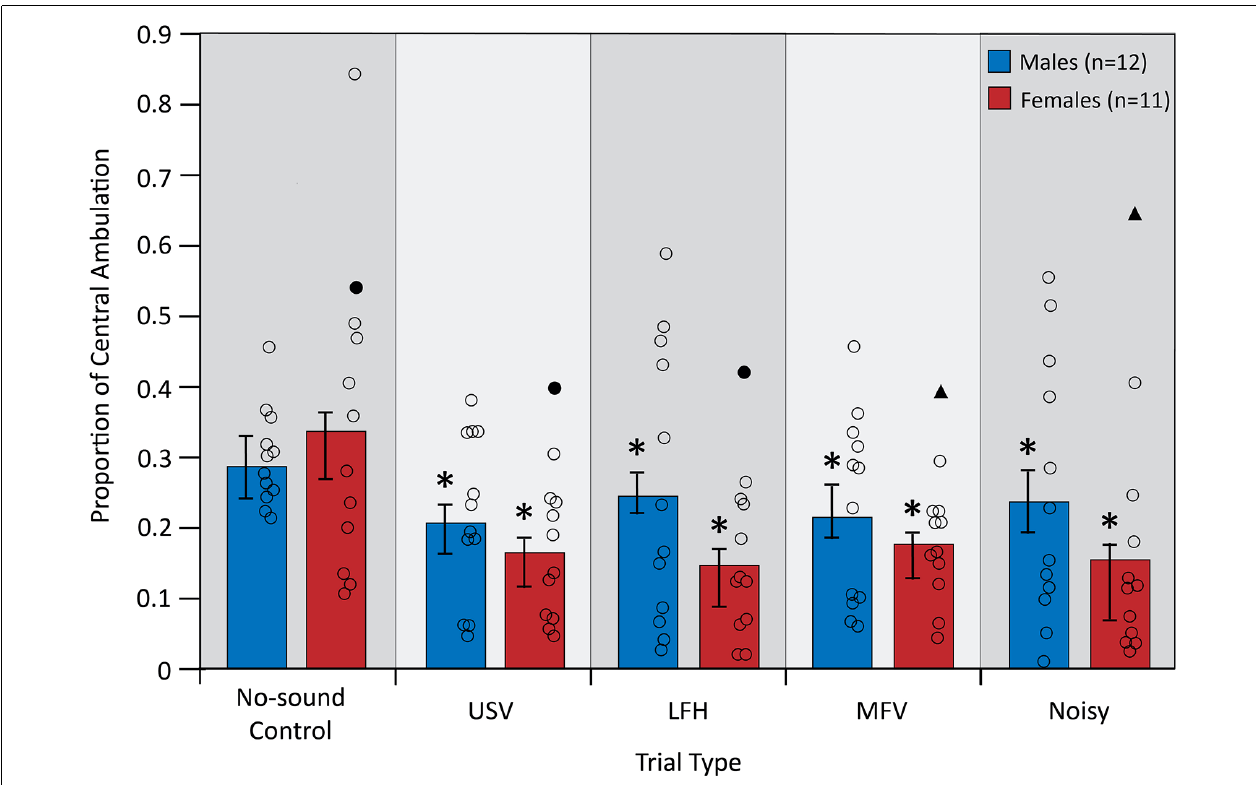
FIGURE 5 | Central ambulation decreased from no-sound control for all vocalization categories. For symbols, see Figure 4 . Outlier data excluded from this analysis (filled triangles and circles) were not from the same animal as in Figure 4 . *Differs from no-sound control, p <